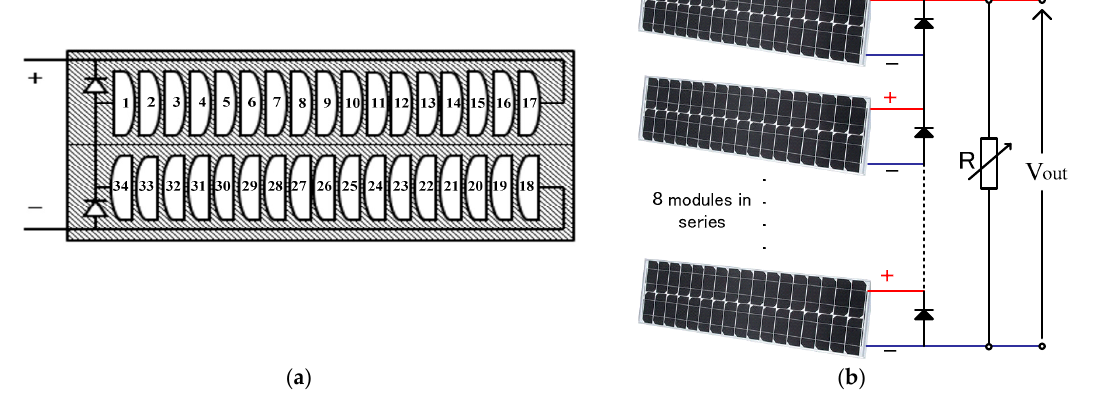
Figure 7. ( a ) Module constitution; ( b ) Layout of experimental PV string. Table 1. PV solar module specifications.